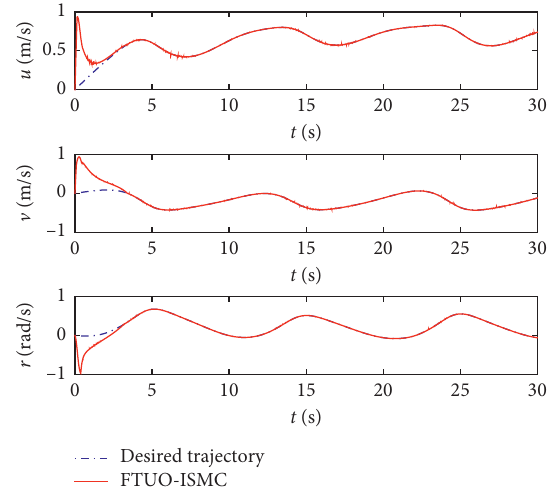
Figure 16: Velocity tracking on FTUO-ISMC.